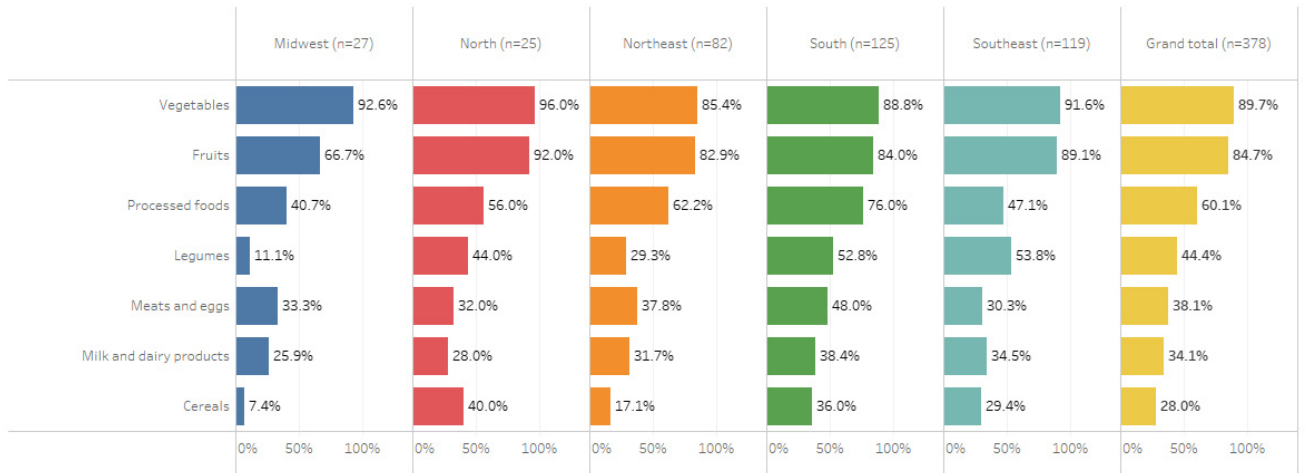
Figure 3. Food groups purchased from family farming by the food service management units of public institutions that implement the government’s food procurement policy, stratified by region of the country.